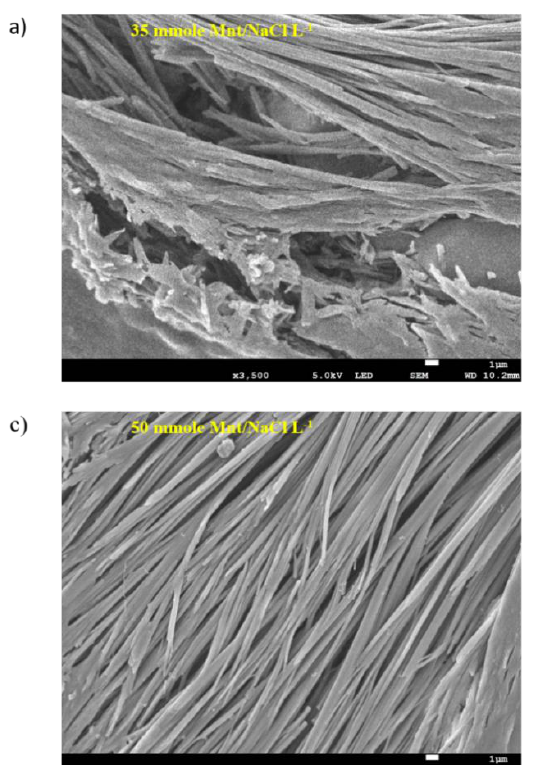
11 of 23 Figure 5. FTIR spectra of pure sodium deoxycholate (Na-DOC) and gels with 60 mmole L −1 Na-DOC and 35, 45 and 50 mmole L −1 concentration of Mnt/NaCl (1:1 mmole L −1 concentration ratio of Mnt/NaCl used). 3.1.4. Na-DOC-Hyd Morphology Using FESEM The microstructure of the hydrogel samples with various Mnt/NaCl concentrations (35, 45 and 50 mmole L −1 ) were investigated using FESEM. The microscopic observation of the self-assembled microfibril structures may assist in understanding the macroscopic properties of the gels and allow interpretation of the mechanism of self-assembly or gelation of Na-DOC molecules [31,52,53]. As shown in Figure 6a–c, the gels prepared using 45 and 50 mmole L −1 Mnt/NaCl showed relatively better microfiber arrangement with noticeable perforations. Whereas as seen in Figure 6a, sample prepared using 35 mmole L −1 Mnt/NaCl showed deformed pores and the pores are have no regularity and the size widest of all samples. In particular, the gel formed using 50 mmole L −1 Mnt/NaCl showed network structure with intertwined microfibrils and relatively medium and homogenous interspersed pockets (Figure 6c). The pores observed between the intertwined microfibrils in the